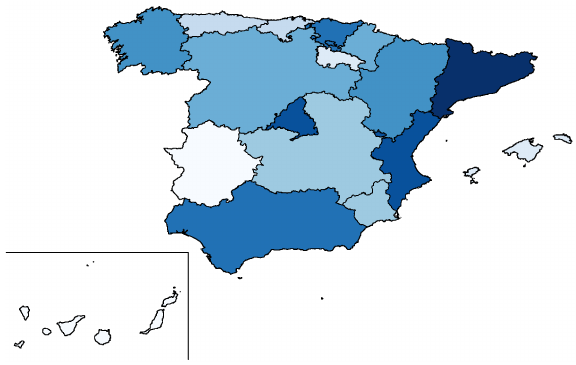
Figure 2: Average Spanish exports in 2008, by